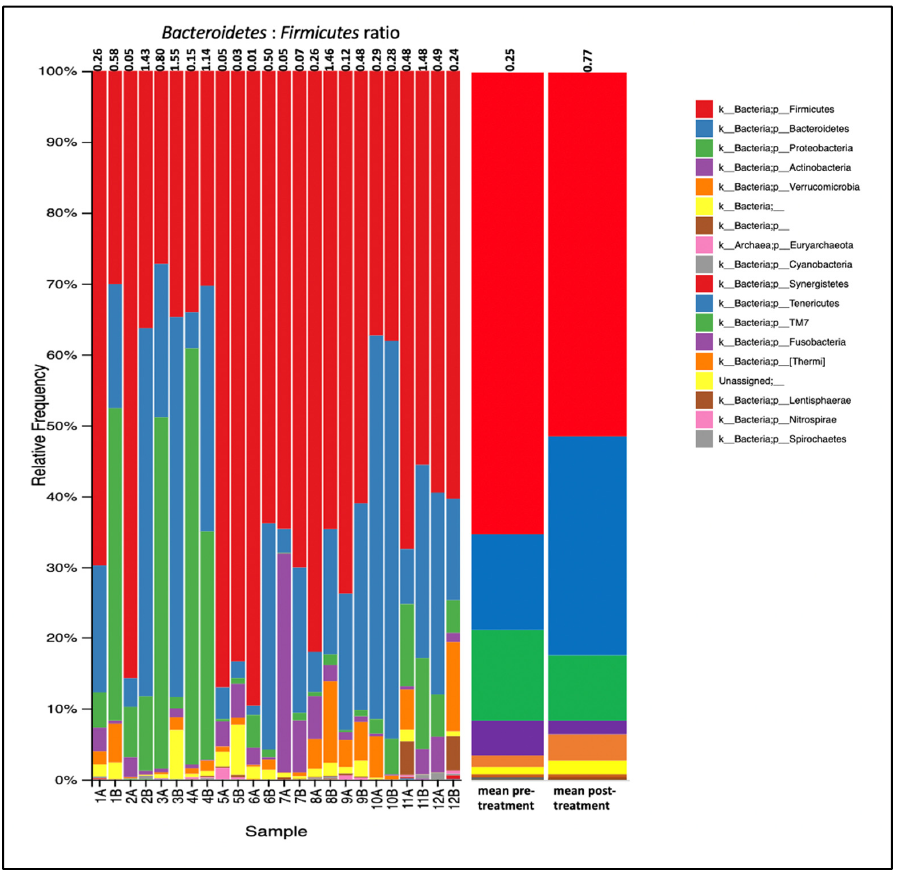
Figure 1. Stacked bar chart indicating the relative abundances of phyla detected in the gut microbiomes of PD participants before (pre-) and after 12 weeks (post-) of PBM treatment. A = pre-treatment; B = post-treatment.